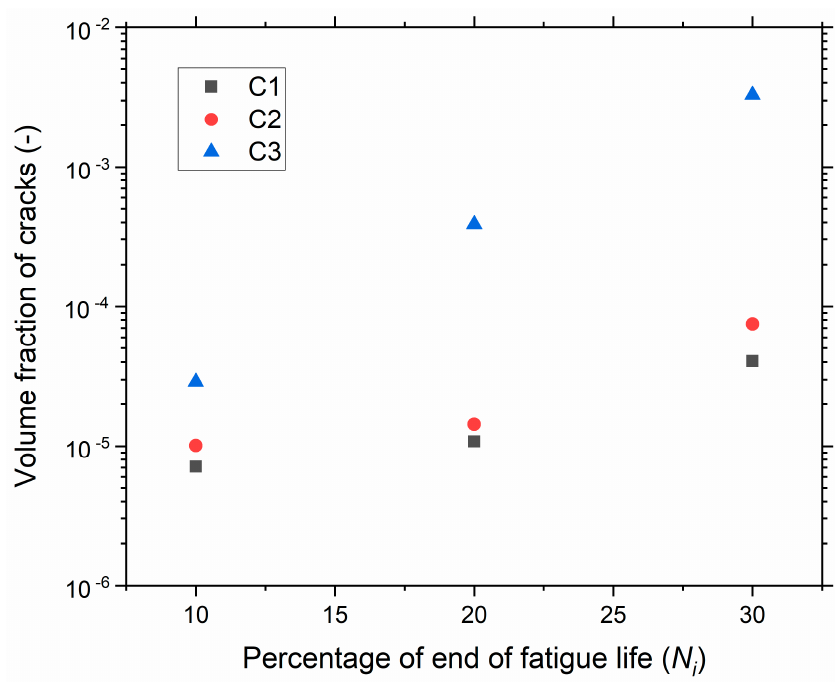
Figure 10. Volume fraction of cracks versus percentage of end of life using µCT.